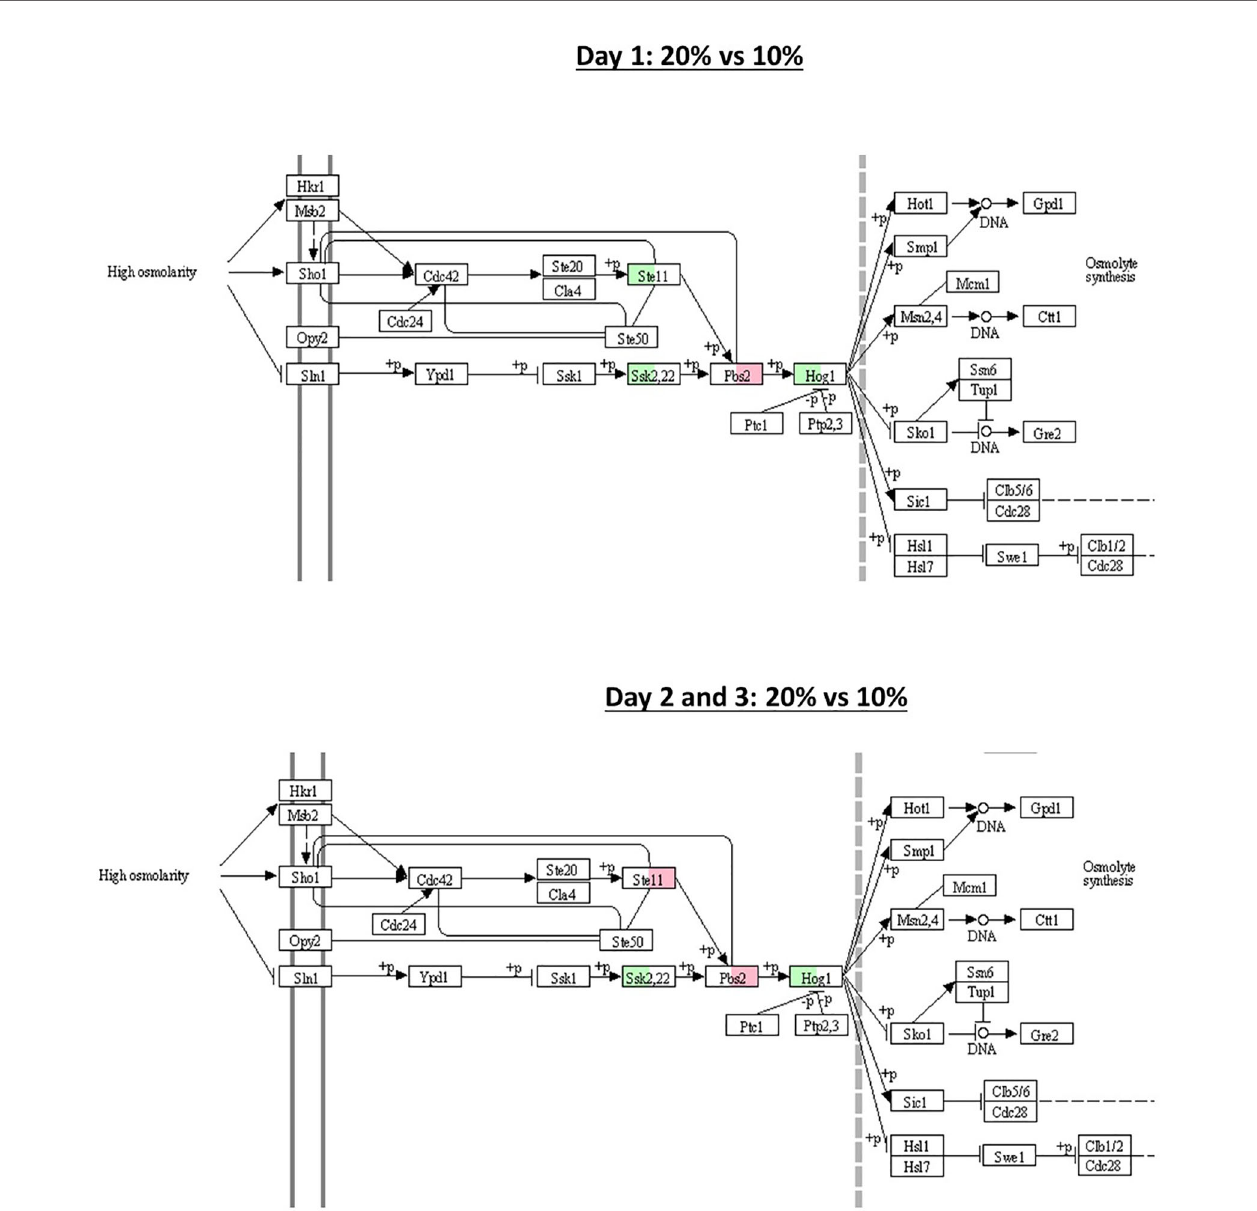
FIGURE 8 | Schematic illustration of MAPK-signaling pathway with 5 selected genes ( Ssk1 , Pbs2 , Ste11 , Hog1 , and Ssk2 ), known to be associated with response to osmotic stress. Green and red boxes indicate the gene is active (log2-FC > 0) in 20% and 10% glucose (log2-FC < 0) treatment, respectively (see also Supplemental Table S4 ). The pathway was obtained from the Kyoto Encyclopedia of Genes and Genomes pathway (KEGG)